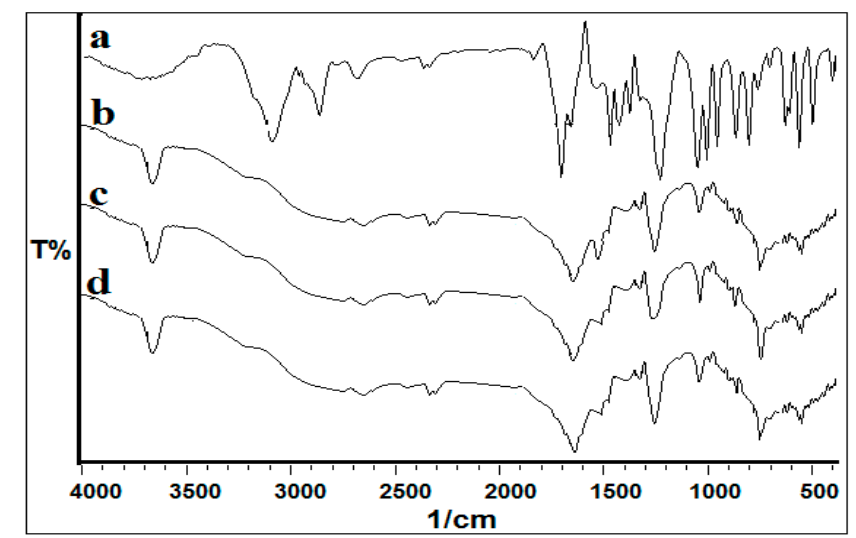
Figure 3. FTIR analysis of acephate ( a ), and its metabolites after 30th day ( b , c & d ). Here a , b, and c represent the FTIR spectrum of metabolites with respect to P. aeruginosa, P. putida, and P. azotoformans strains.